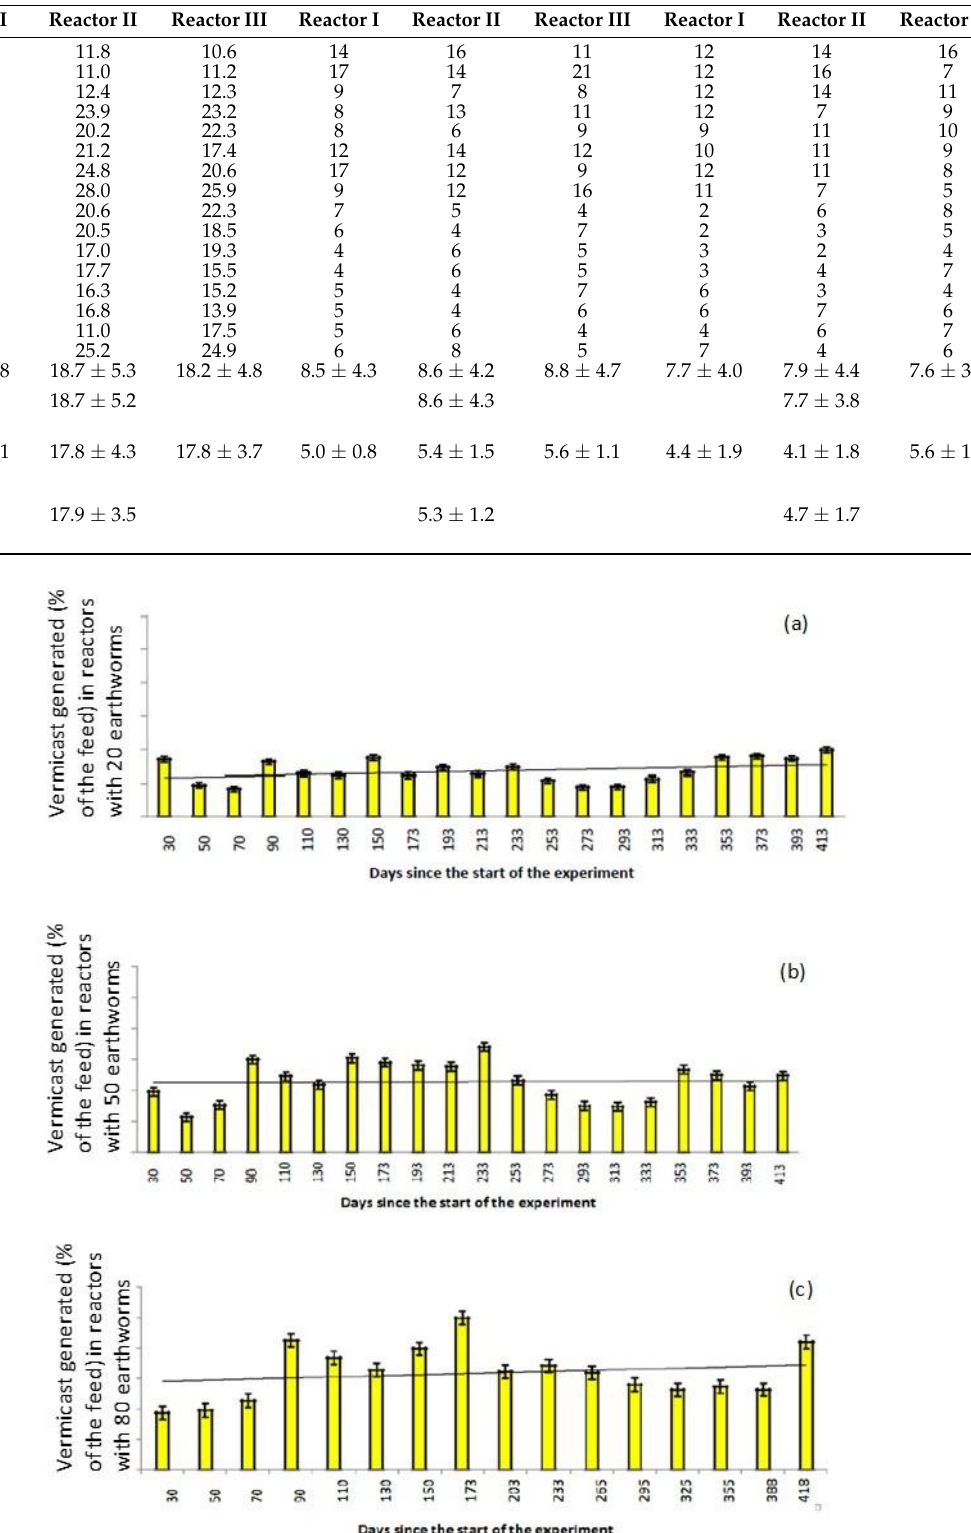
Figure 4. Trend in the generation of vermicast as a function of time in pulse-fed, semi-continuous reactors operated with ( a ) 20, ( b ) 50, and ( c ) 80 earthworms with fresh ipomoea. Ipomoea also differed from other feeds in the sense that crowding of earthworms seemed to effect the per capita vermicast generation more than it did for the other two feeds, as reflected in an almost 50% drop in 50 animals per kg reactors compared to the 20 animals per kg reactors.